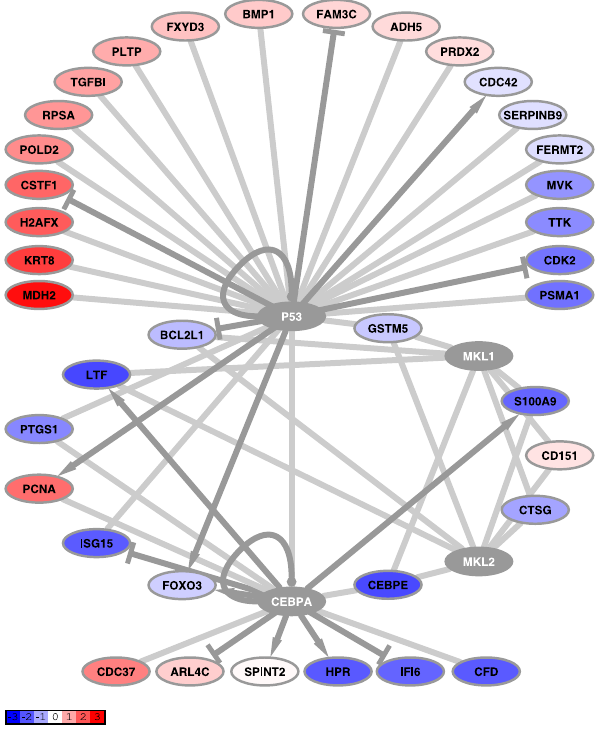
Figure 3. Survival-associated genes are transcriptionally inter- connected. A network illustrating transcriptional connections between 37 genes which distinguish between ‘‘EBOV-infected, Treated Survivors’’ (ETS), ‘‘EBOV-infect, Treated Non-Survivors’’ (ETNS), and NHPs that did not receive anticoagulant treatment (‘‘EBOV Only’’; see Materials and Methods ). Nodes are labeled with the gene name, edges indicate regulation of expression from transcription factor to target gene; arrows indicate up-regulation, bars indicate down-regulation, circles indicate up- and down-regulation, and unmarked, light grey edges indicate unknown regulation. Nodes are colored according to the difference in mean expression between the ETS and ‘‘Non-Survivor’’ (NS; ETNS and EO) groups; blue indicates lower expression values in the ETS group compared to the NS group, red indicates higher expression values in the ETS group compared to the NS group (scale indicated). Nodes that are colored grey ( e.g. p53) are master transcriptional regulators which were not identified as being differentially expressed by our